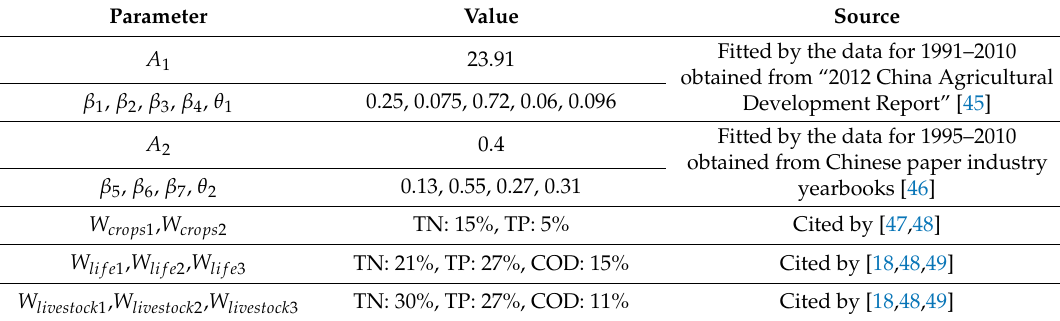
Table 1. The values of the related